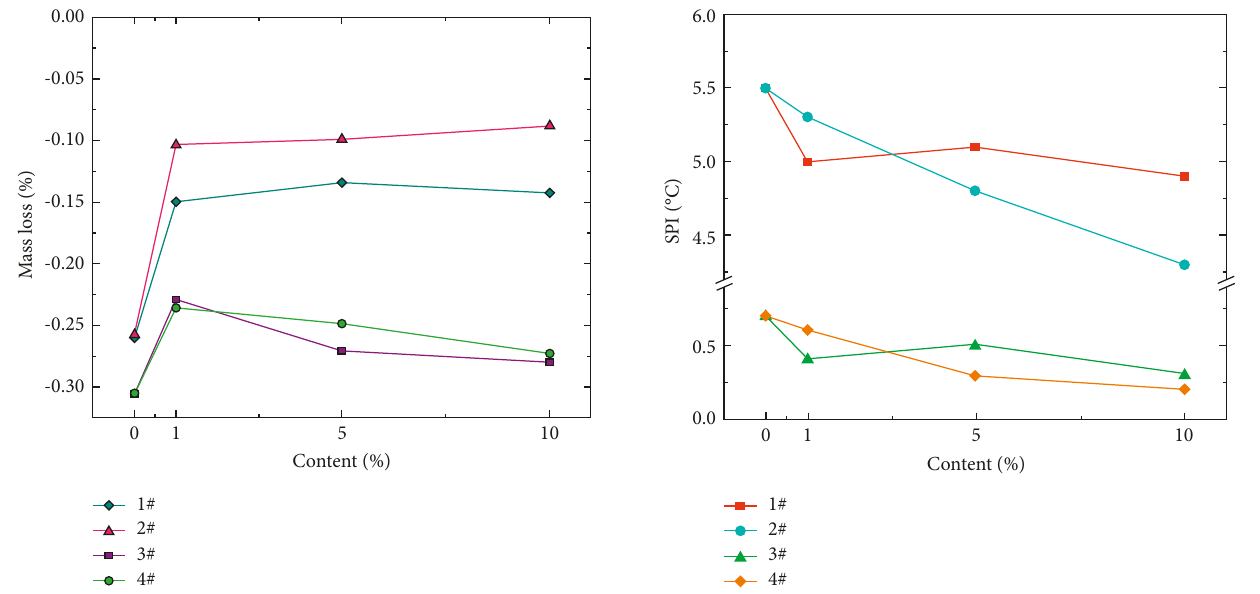
Figure 3: Mass loss of different types of asphalt.